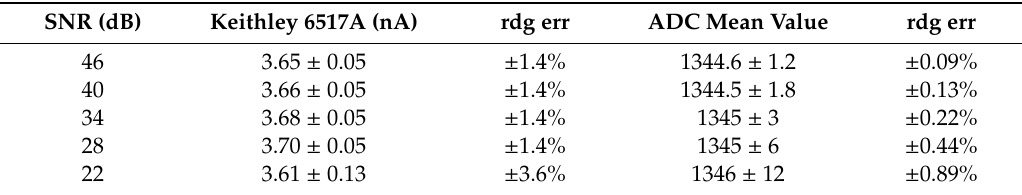
Table 2. Noise performances of gated integrator circuit ( Ti = 40 µ s) and a Keithley 6517A electrometer for 10 pC, 10 µ s wide, input charge pulses sourced by an AC / DC current source (Keithley 6221) injected by means of the test fixture illustrated in Section